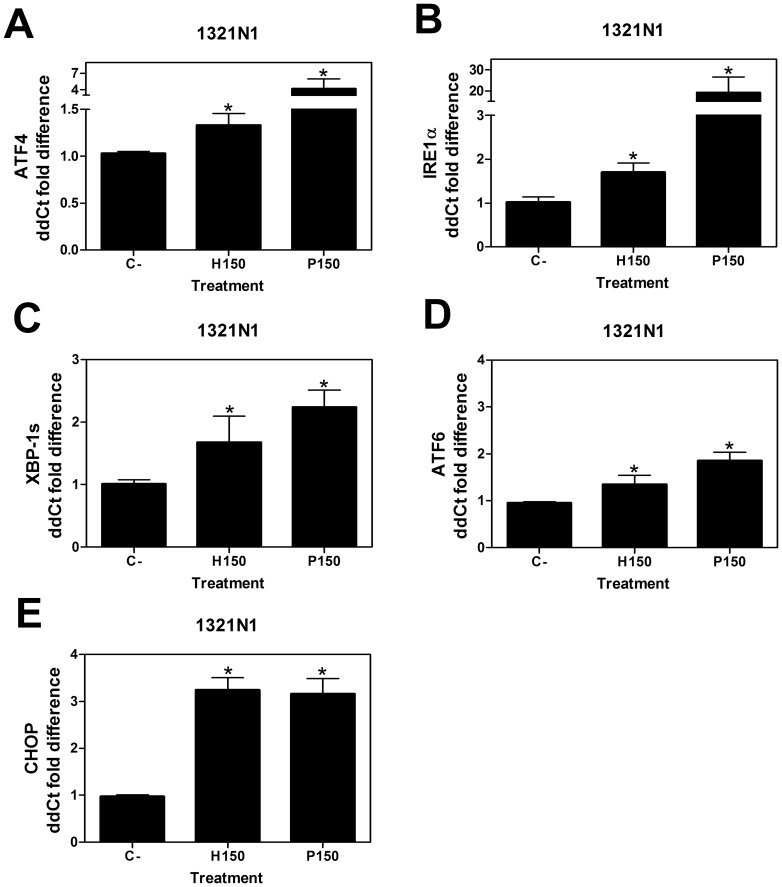
Relative mRNA levels of ER stress/UPR transcripts.q RT-PCR analysis of the mRNA expression of ATF4 (A), ; IRE1α (B); spliced form of XBP1 (C) ; ATF6 (D) and CHOP (E) genes in 1321N1 human astrocytoma cells after treatment with 2OHOA (H) or palmitate (P) (150 µM; 24 h). Results are expressed as ddCt values using the following formula: ddCt = E X(Ctc-Ctx)/E Bact(Ctc-Ctx). (*P<0.05; n = 6) in a bar diagram showing the mean±SEM (standard error of the mean).